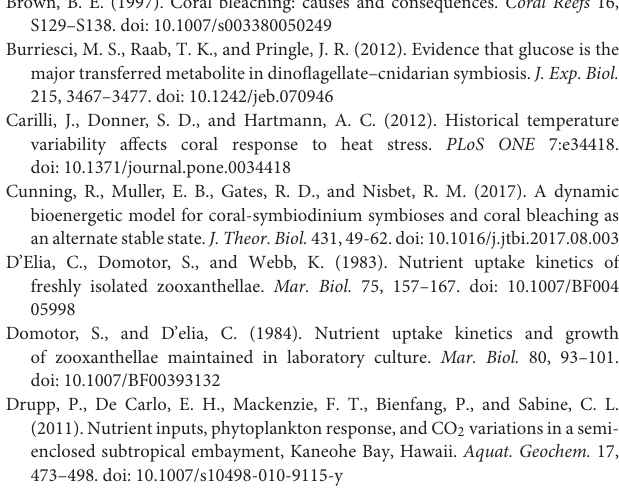
(data derived from automatic weather station of PacIOOS at HIMB, Point Lab, from ∼ 1m water depth). Solid line indicates 10-year MMM ± 1SD. Table S1 | The effect of acclimation on the global scale physiological response of Pocillopora damicornis to a simulated bleaching event. Dependent variables were analyzed by a restricted maximum-likelihood (REML) linear mixed model with acclimation and time as fixed factors. Colony was included as a random factor to assess how much of the variance in the data was explained by the source colony that each fragment originated from (variance components analysis). A minimal model approach was employed whereby acclimation and time were initially crossed to assess their combined effect, but removed if their interaction was non-significant (–).Degrees of freedom (d.f.), F-ratios (F) and probability levels ( P ) are provided and significant effects ( P < 0.05) are in bold. Table S2 | Summary of enrichment values for carbon and nitrogen from NanoSIMS image analysis. Regions of interest (ROI) were based on coenosarc cross sections and refer to the oral tissue layer. Gastrodermis ROIs refer to gastrodermis excluding symbionts, but including host